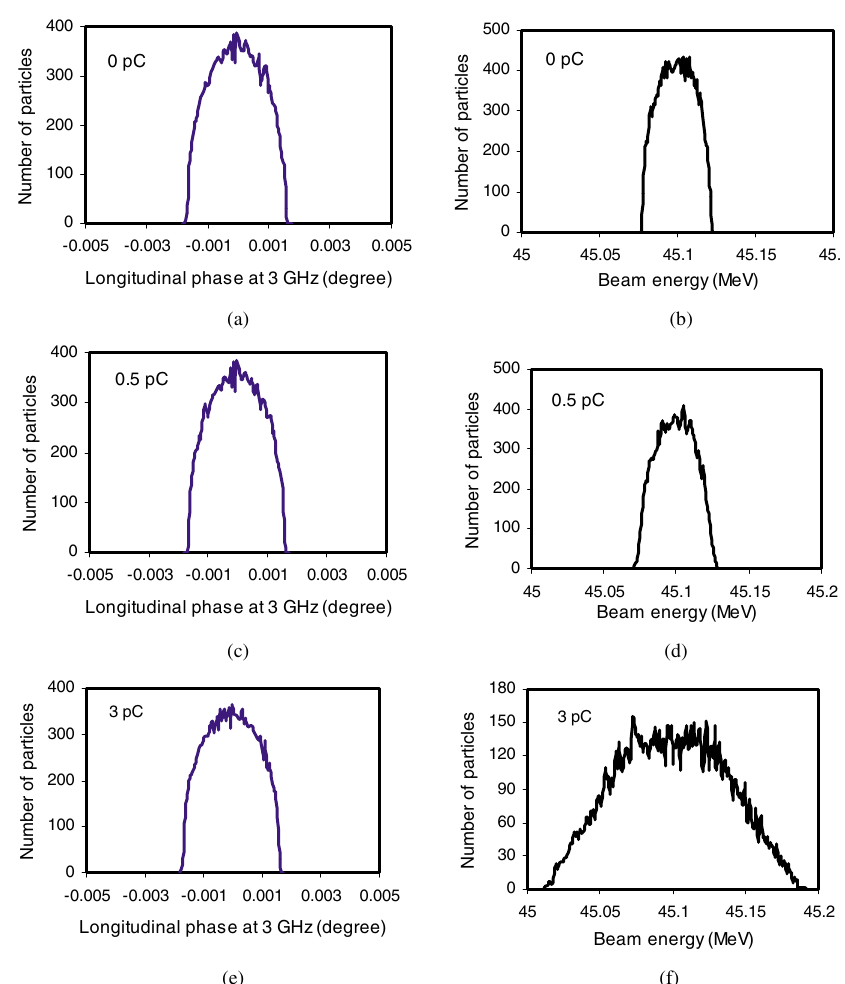
FIG. 2. (Color) Longitudinal phase spectrum (a),(c), and (e), and energy spectrum (b),(d), and (f) at the entrance to